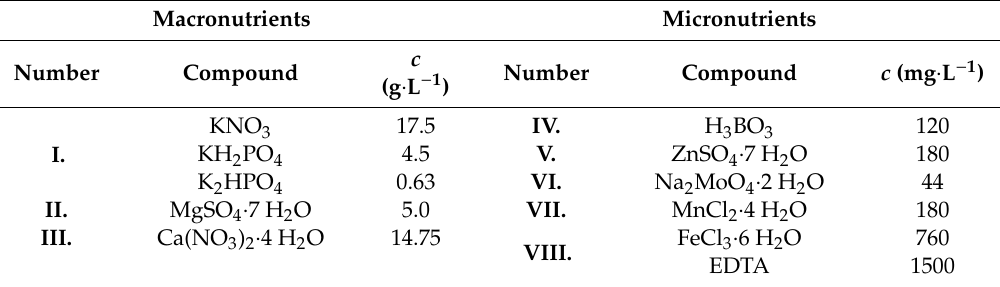
Table 1. Ingredients of the modified Steinberg